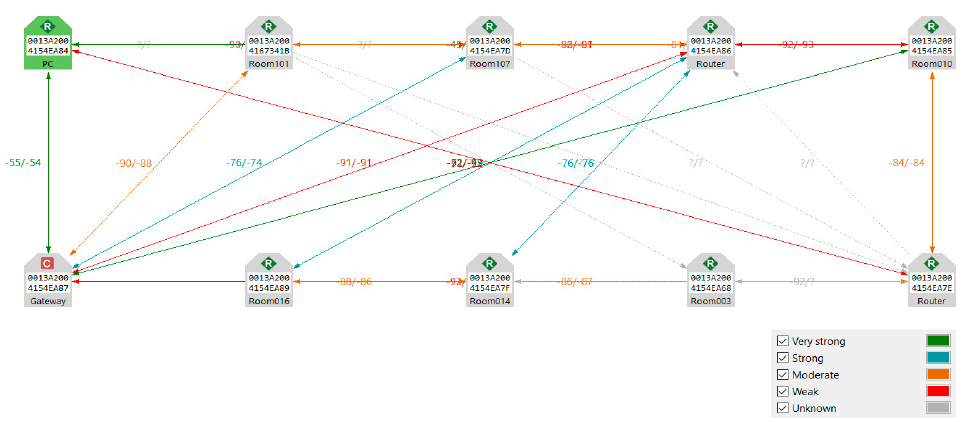
Figure 7. Link quality between WSN nodes.